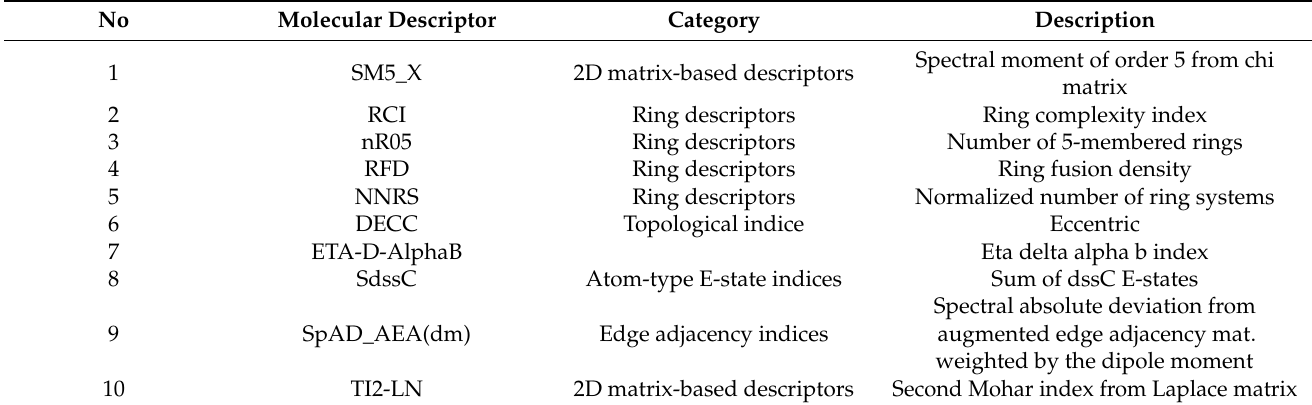
Table 1. Molecular descriptors with respective categories and